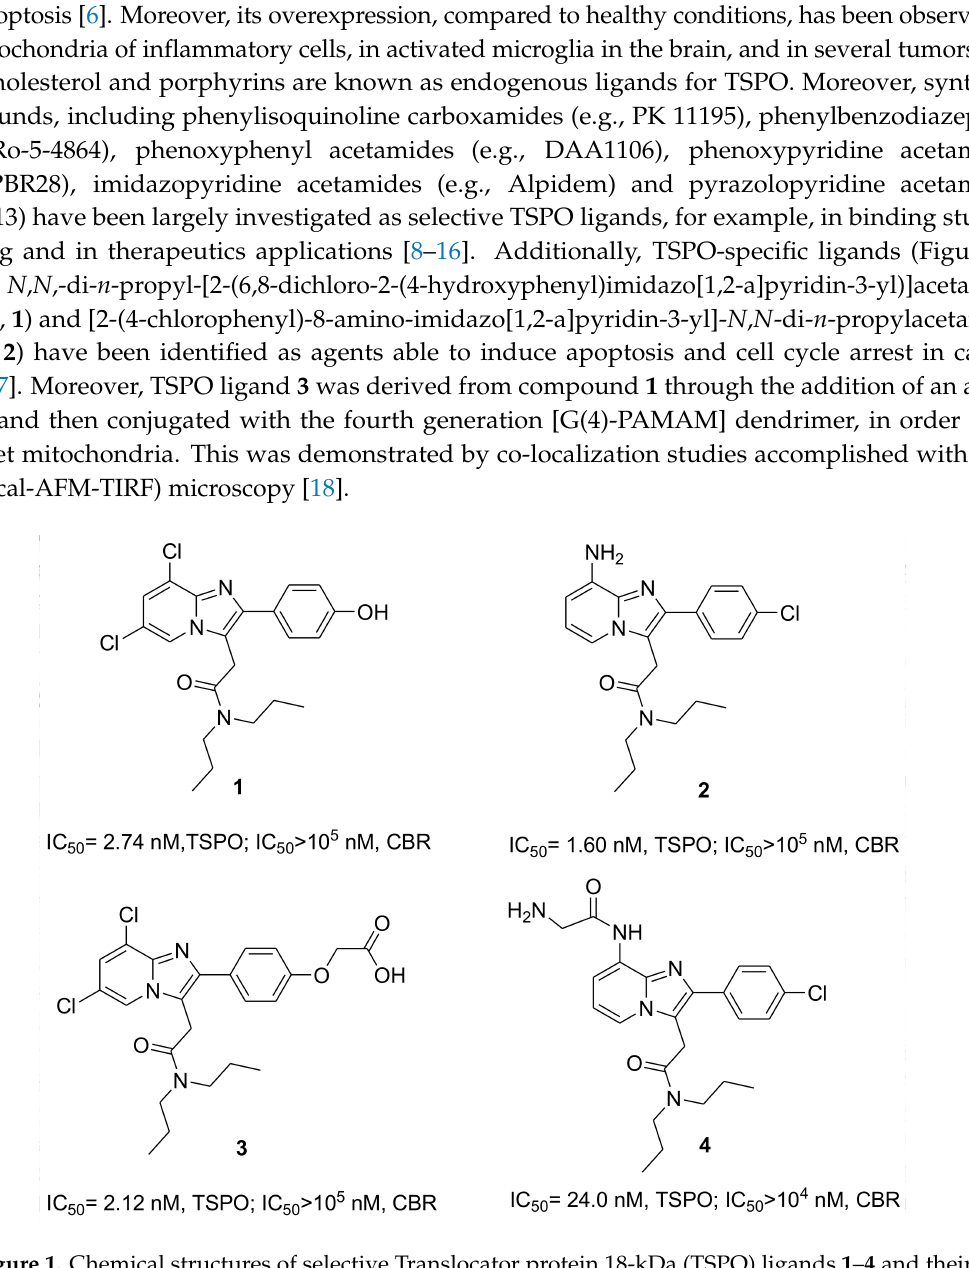
Figure 1. Chemical structures of selective Translocator protein 18-kDa (TSPO) ligands 1 – 4 and their affinities and selectivity vs. central-type benzodiazepine receptor